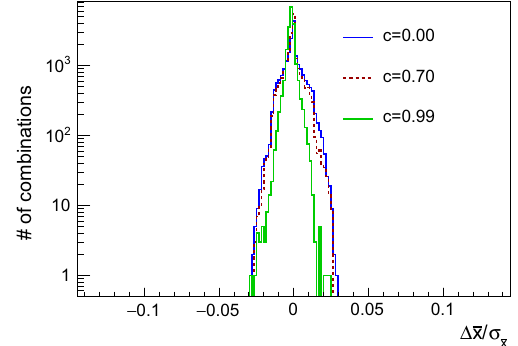
Fig. 3 Ratio of the uncertainties on the combined value obtained using the method proposed here and the direct likelihood combination, shown for different values of the upper threshold for systematic uncertainties t